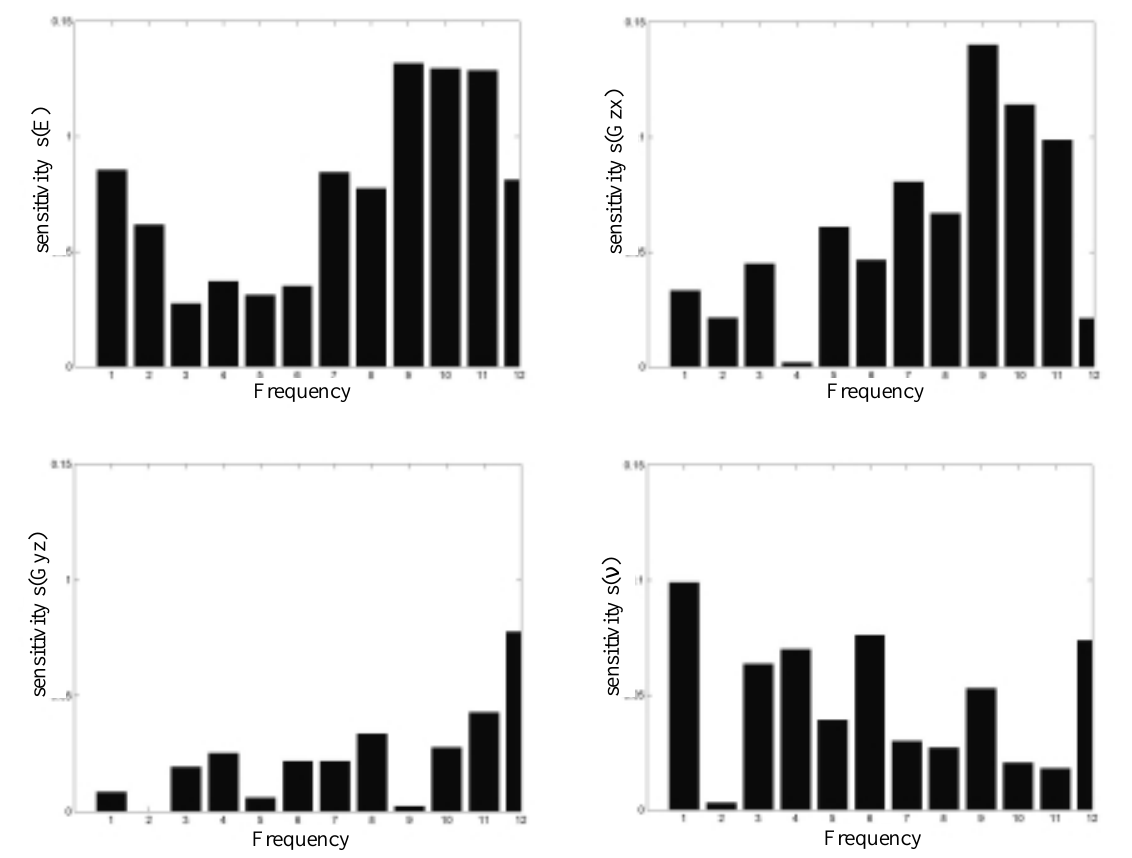
Fig. 4. Sensitivity coefficients for a free edge sandwich